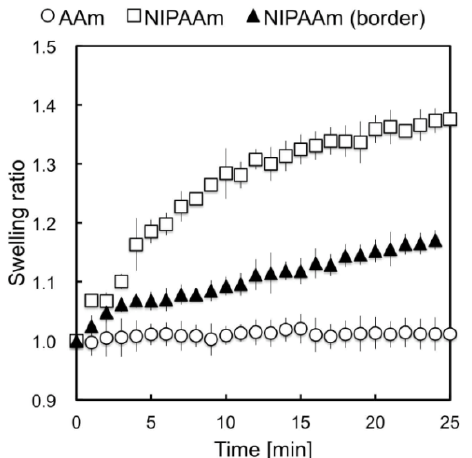
Figure 2. Swelling kinetics of combined gels. Temperature changes from 37 °C to 32 °C were applied to the gel (0 min). The swelling ratio against time was measured at five locations on the each section of the gel. Because the PNIPAAm did not swell evenly as a result of the effect of anchoring, whole-gel deformation was continuous. Open square; the collagen-immobilized PNIPAAm gel at a distanced from the border section. Closed triangle; the collagen-immobilized PNIPAAm gel side near the border section (within 100 μ m). Open circle; the collagen-immobilized PAAm gel side at a distance from the border section. Values are mean ± SEM ( n =